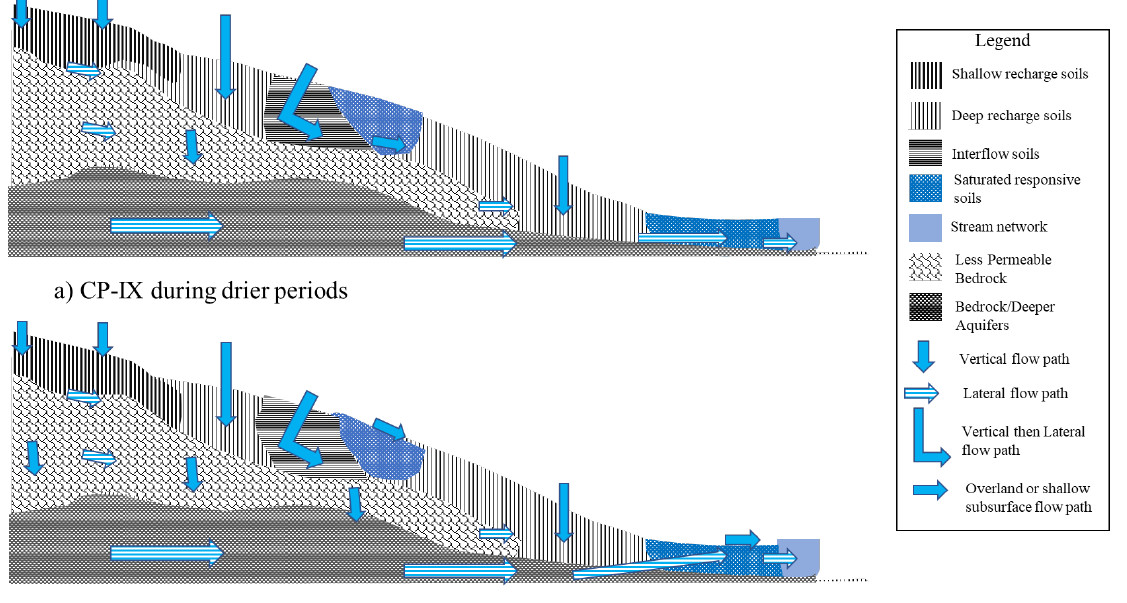
Figure 9. Flow path diagrams for ( a ) the drier periods and ( b ) wetter periods for CP-IX.